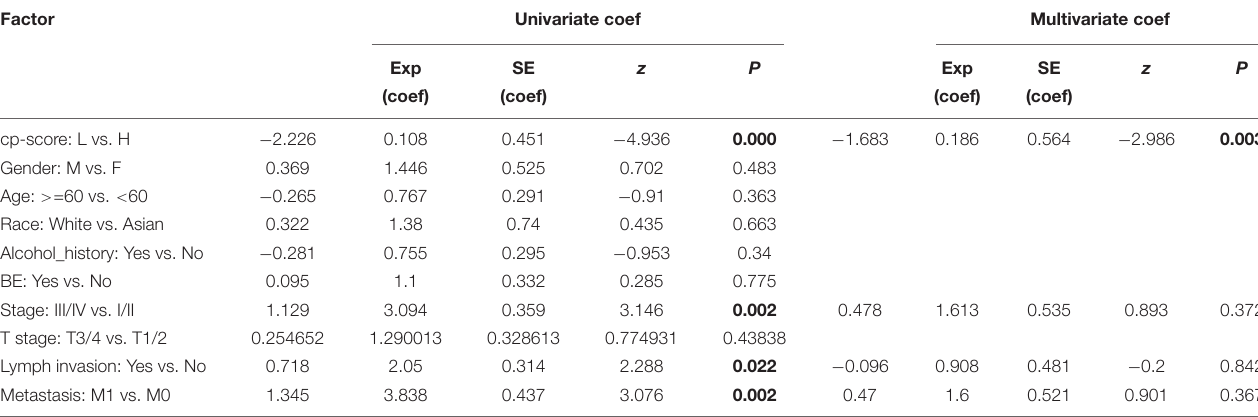
TABLE 1 | Univariate and multivariable Cox regression analysis with covariates including cp-score, gender, age, race, alcohol, BE, stage, and T stage, lymph invasion and metastasis for overall survival. Factor Univariate coef Multivariate